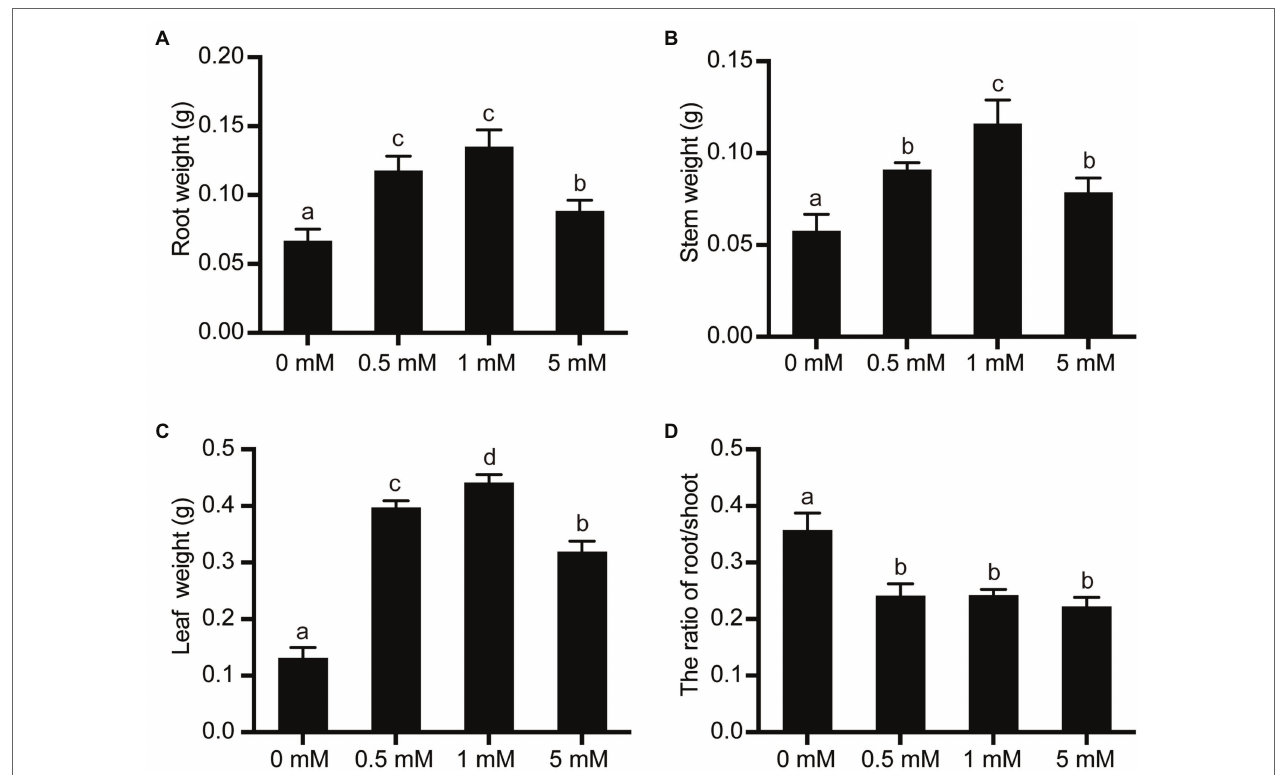
FIGURE 3 | The effects of P treatments on the organ weight and root/shoot ratio in pear seedlings. (A) Root FW per pear seedling; (B) Stem FW per pear seedling; (C) Leaf FW per pear seedling; and (D) Root/shoot FW ratio. Data are presented as mean ± standard deviation of three replicates, and each replicate is based on measurements made from three plants. Samples in a bar chart with a common superscript letter are not significantly different ( p > 0.05), according to the Duncan’s multiple range